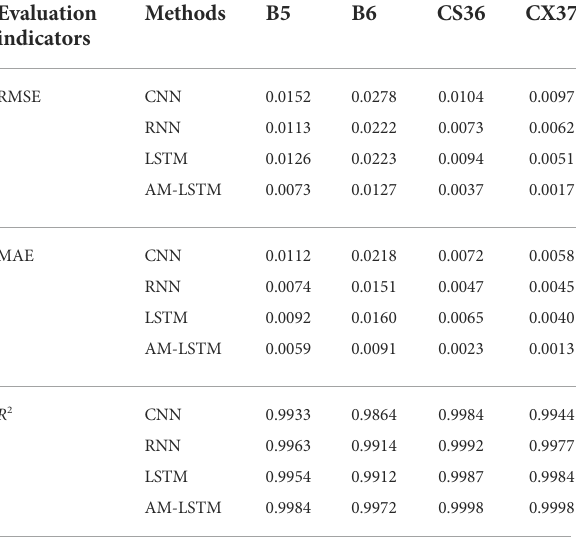
TABLE 3 The performance evaluation indicators of the proposed method compared with other neural networks. Evaluation